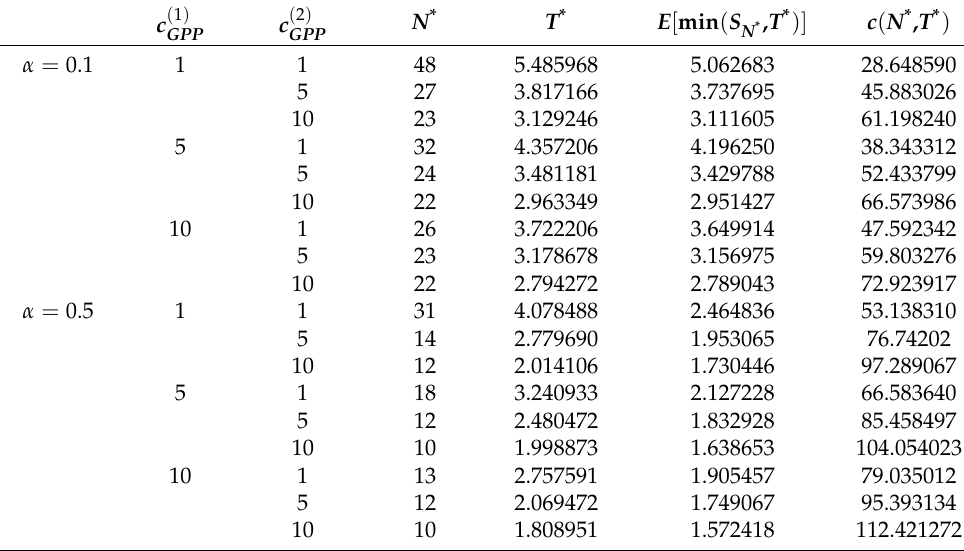
( i ) , i = 1,2 ( c r = GPP